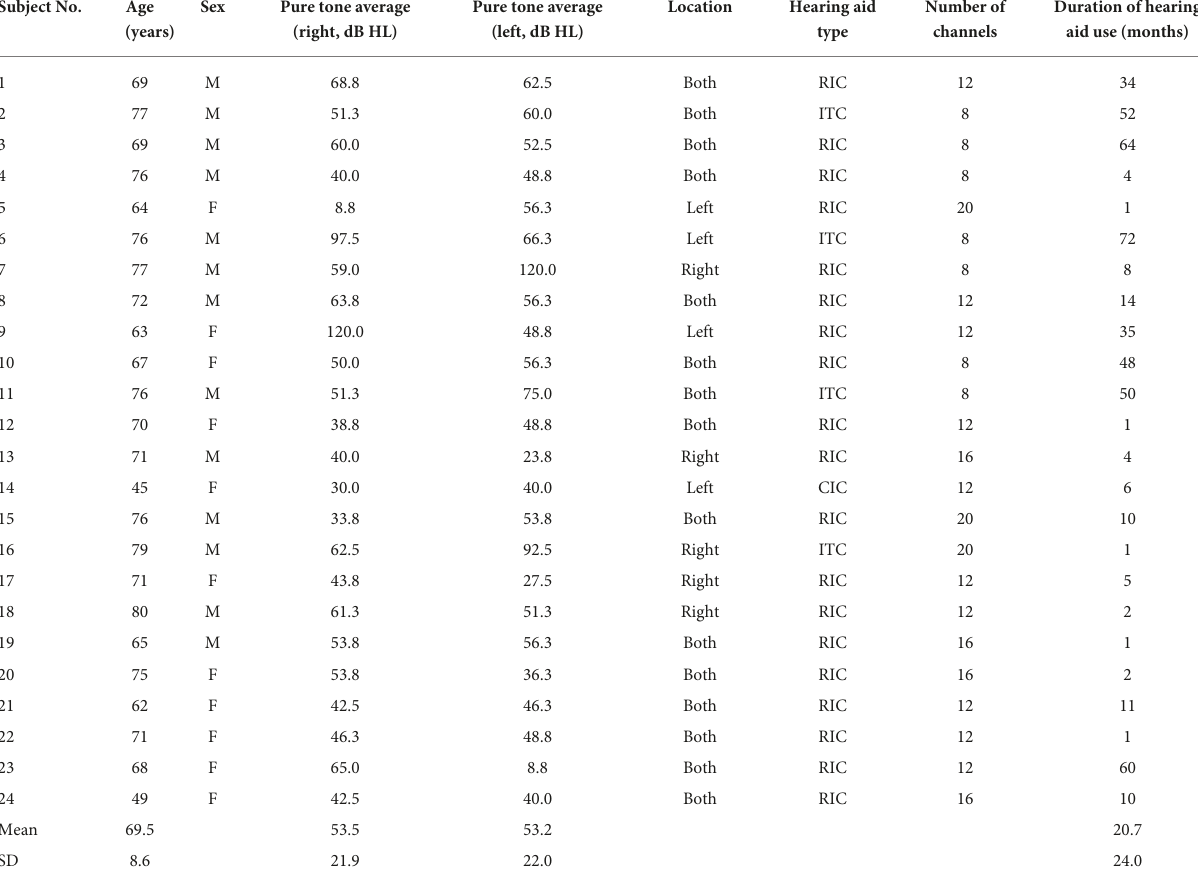
TABLE 1 Age, sex, hearing thresholds, and characters of hearing aids in the hearing-impaired group. Subject